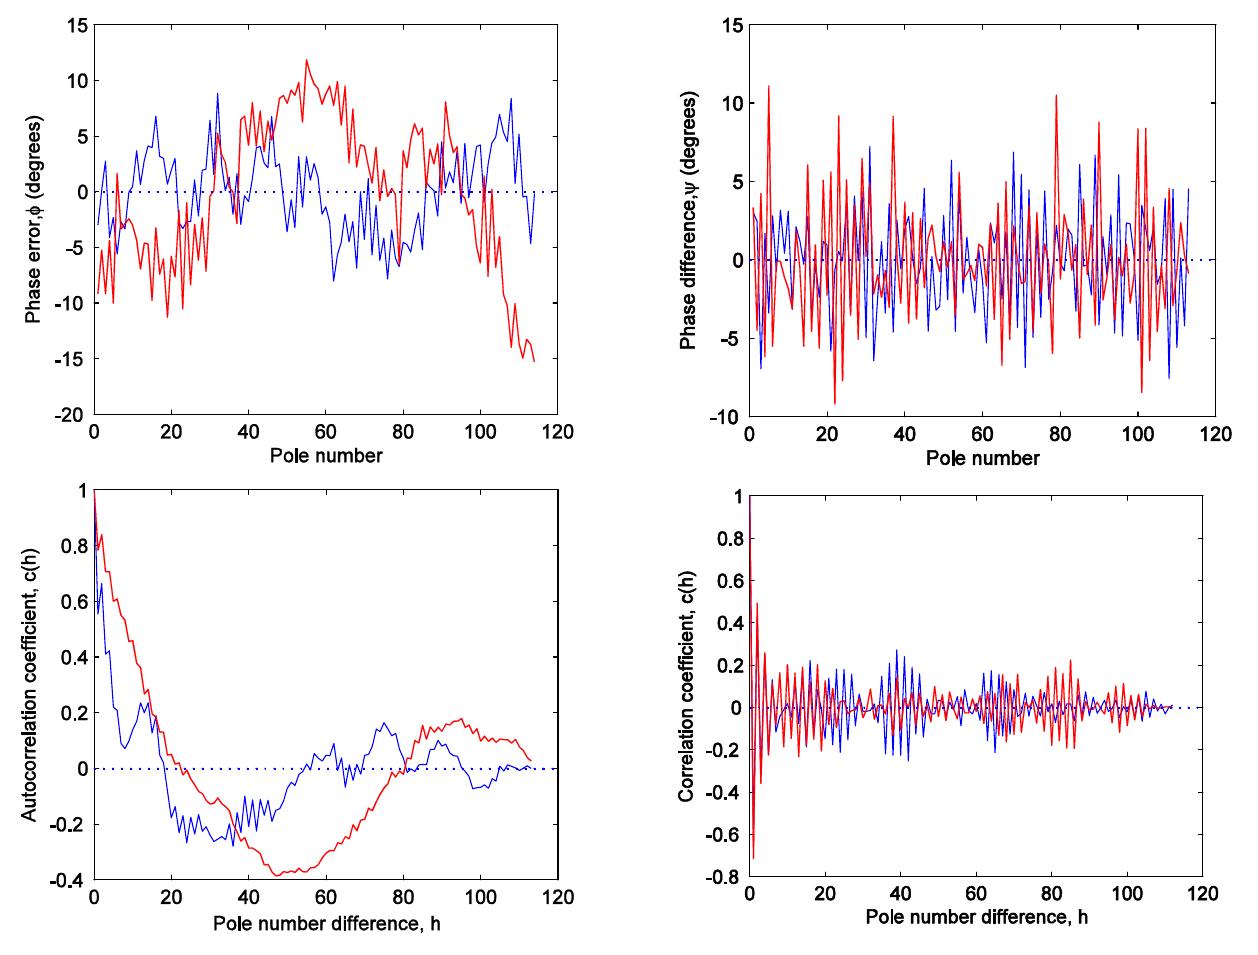
FIG. 6. Phase errors (upper) and autocorrelation coefficients (lower) for the APS low (blue) and high (red) phase error devices.